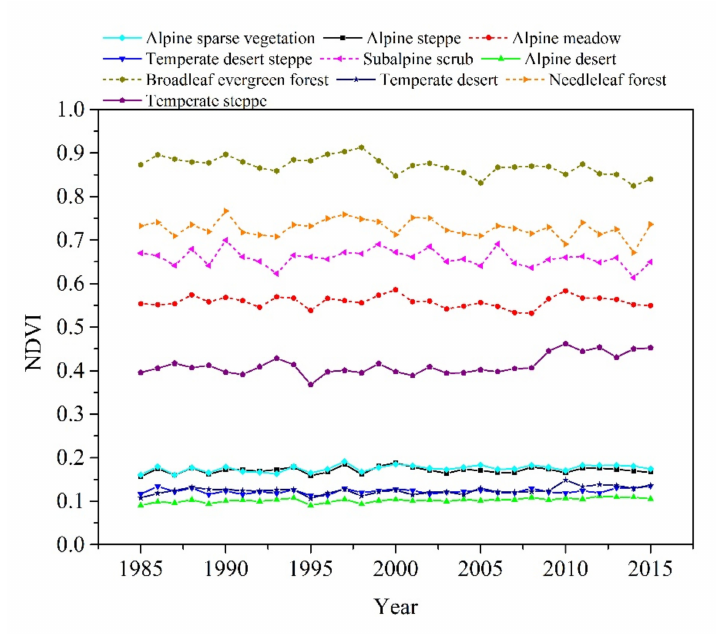
Figure 6. The average NDVI trend during the growing season for all types of vegetation from 1985 to 2015. The dashed line indicates that the NDVI of this vegetation type showed a decreasing trend during the study period. The solid line indicates that the NDVI of this vegetation type showed an increasing